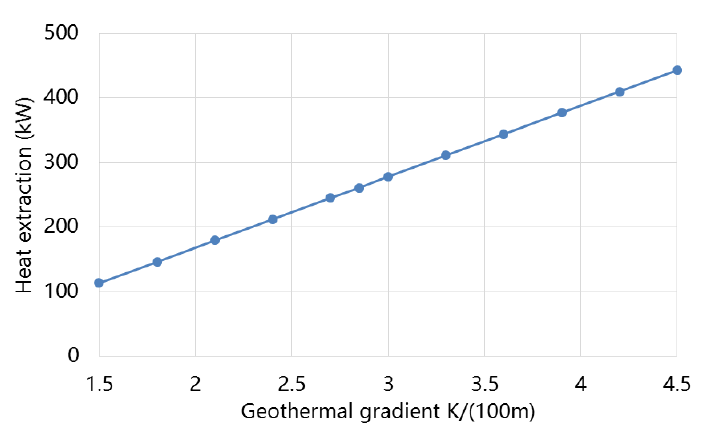
Figure 17. Effect of geothermal gradient on the heat extraction of DBHEs.